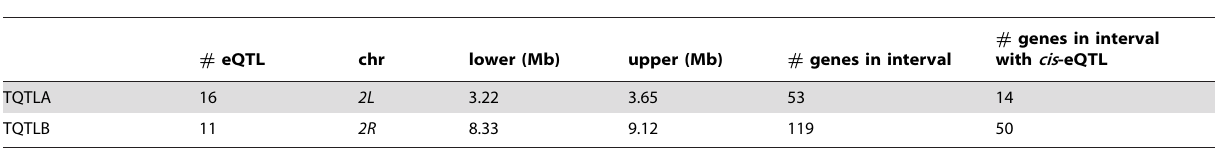
Table 2. trans -eQTL regulating multiple